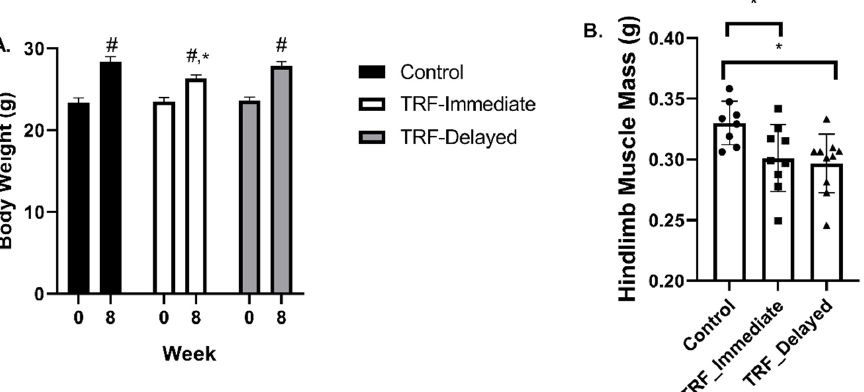
Figure 1. Body weight and muscle mass. ( A ) Body weight measured at the beginning and end of the 8-week study. ( B ) Hindlimb muscle mass consisting of the gastrocnemius, quadriceps, soleus, plantaris, tibialis anterior, and extensor digitorum longus was measured at the time of sacrifice. All muscles were weighed prior to being frozen in liquid nitrogen. All data are presented as mean ± SEM. A repeated measure ANOVA was used to identify differences in body weight over time. An ANOVA was used to measure changes in hindlimb mass. Significance was set at p ≤ 0.05. * significant compared to control at same timepoint. # significant compared to week 0 within